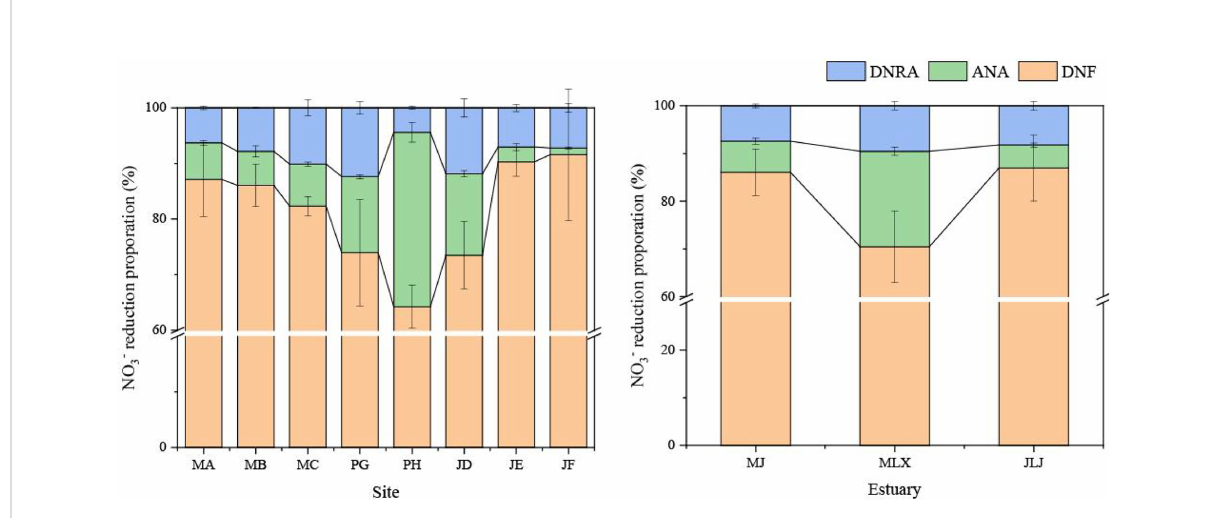
FIGURE 3 Relative contributions of DNF, ANA and DNRA to total NO 3- reduction in the shrimp ponds. Error bars represent the standard